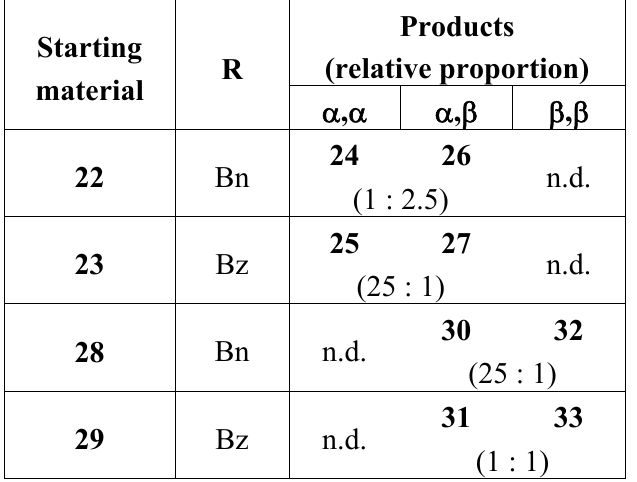
Table 1 . Boron trifluoride-promoted DFA synthesis (n.d., not